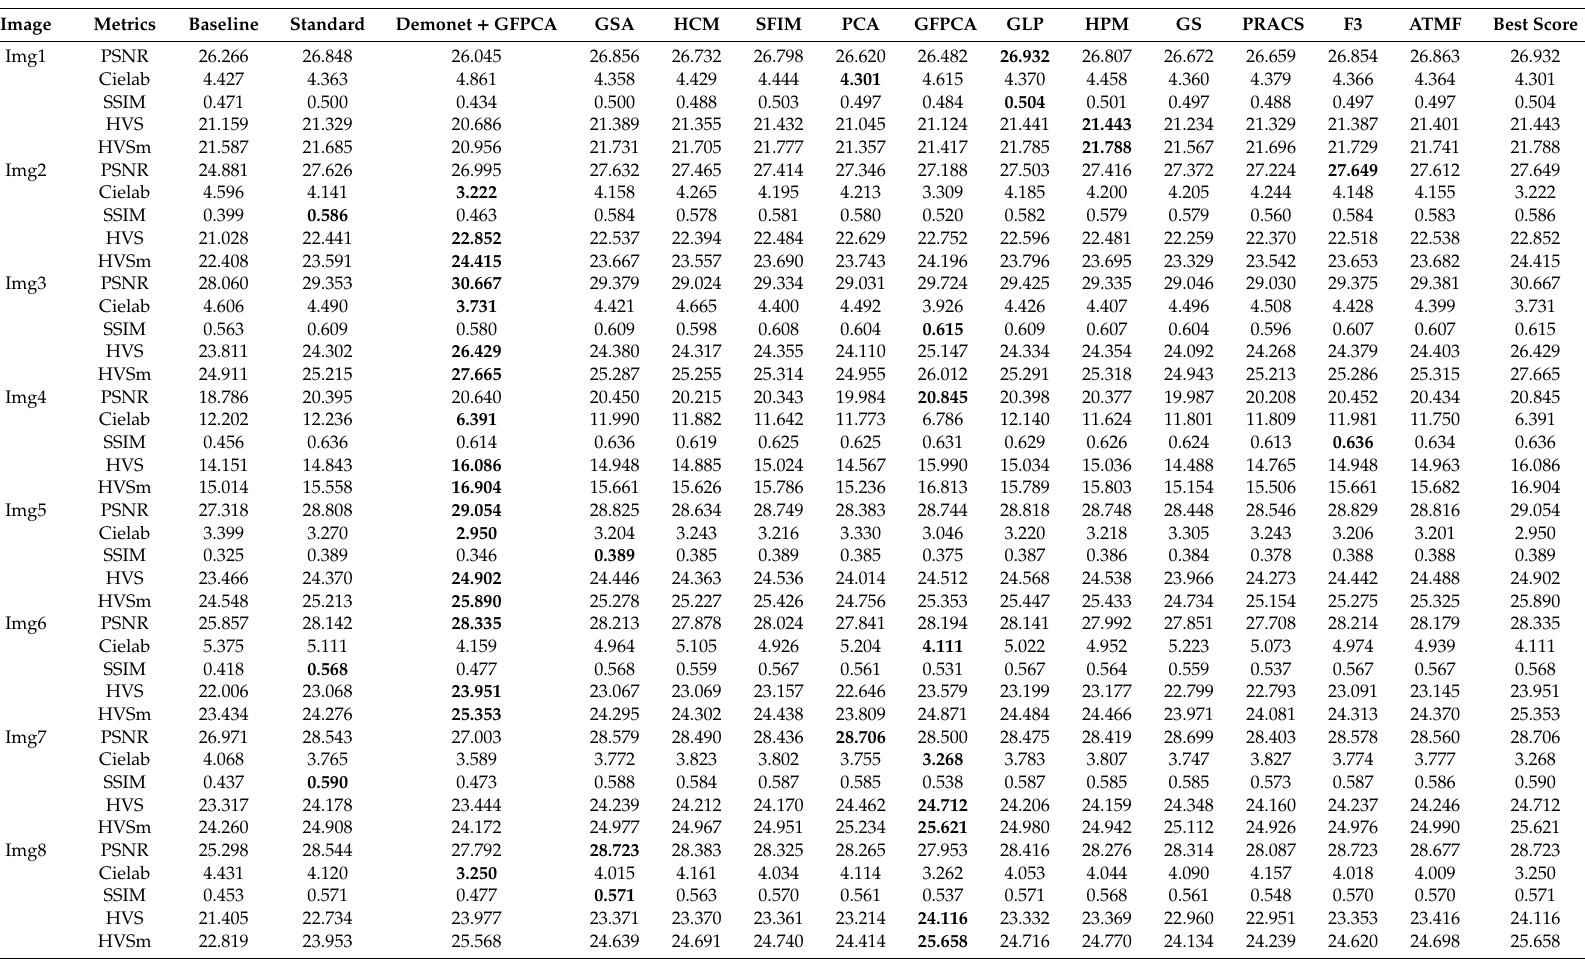
Table A8. Performance metrics of 14 algorithms at 20 dBs SNR (Poisson noise). Bold numbers indicate the best performing methods in each row. Red numbers indicate those methods used in F3 and those red and green numbers indicate those methods used in